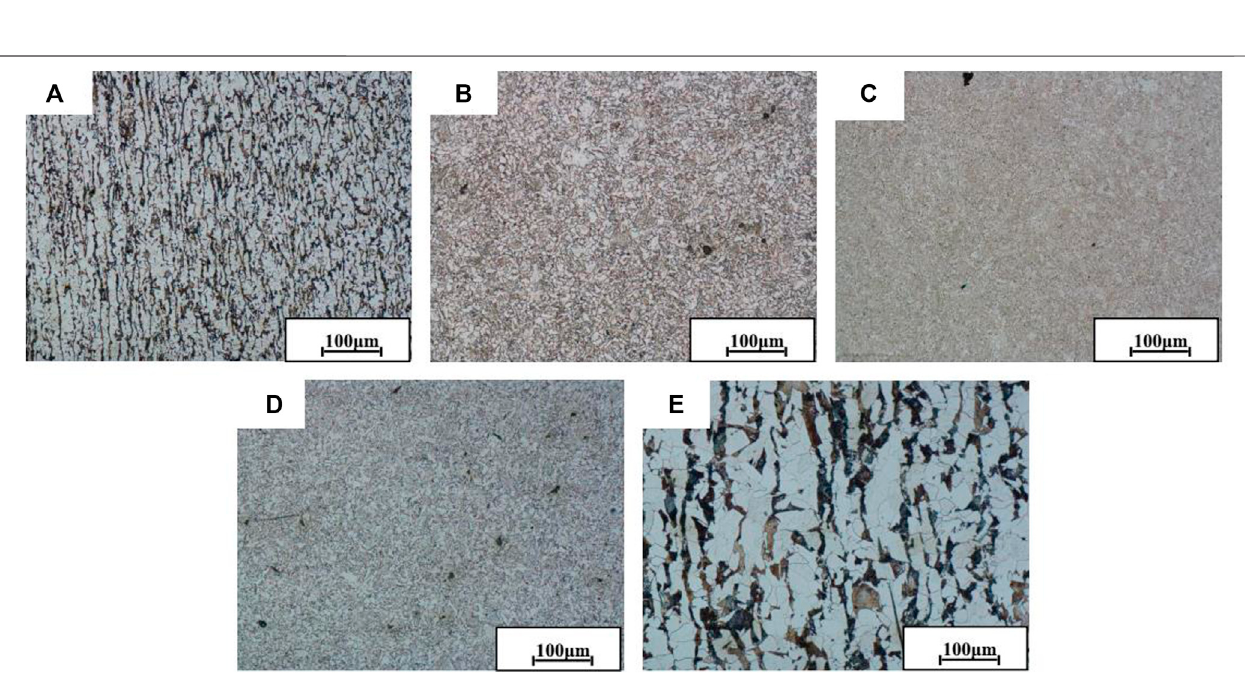
Frontiers in Materials |